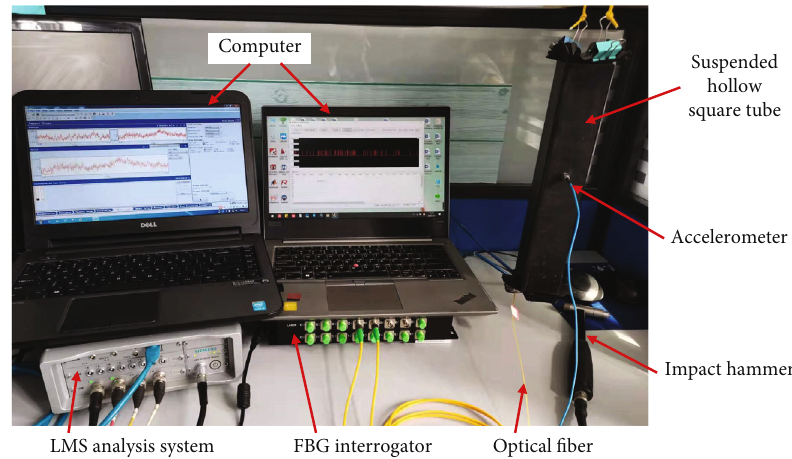
Figure 7: Experimental setup of modal